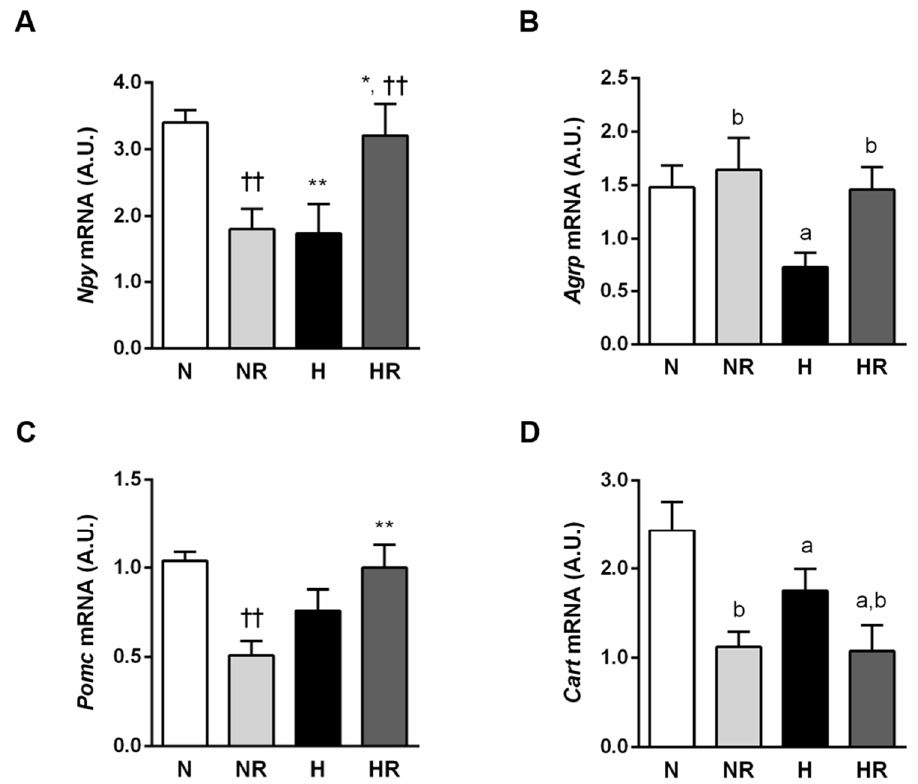
Figure 5. Hypothalamic gene expression of neuropeptides NPY ( A ), AgRP ( B ), POMC ( C ) and CART ( D ) in the arcuate nucleus of the four experimental groups. a p < 0.05 effect of diet; b p < 0.05 effect of caloric restriction. * p < 0.05; ** p < 0.01 vs. the same group fed a ND; †† p < 0.01 vs. the same group fed ad libitum.